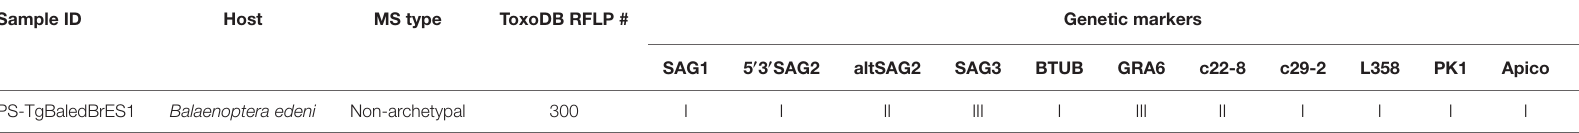
TABLE 1 | Toxoplasma gondii PCR-restriction fragment length polymorphism genotype from a Bryde’s whale ( Balaenoptera edeni ) stranded in Pontal do Ipiranga, Linhares, Espirito Santo state (Brazil).